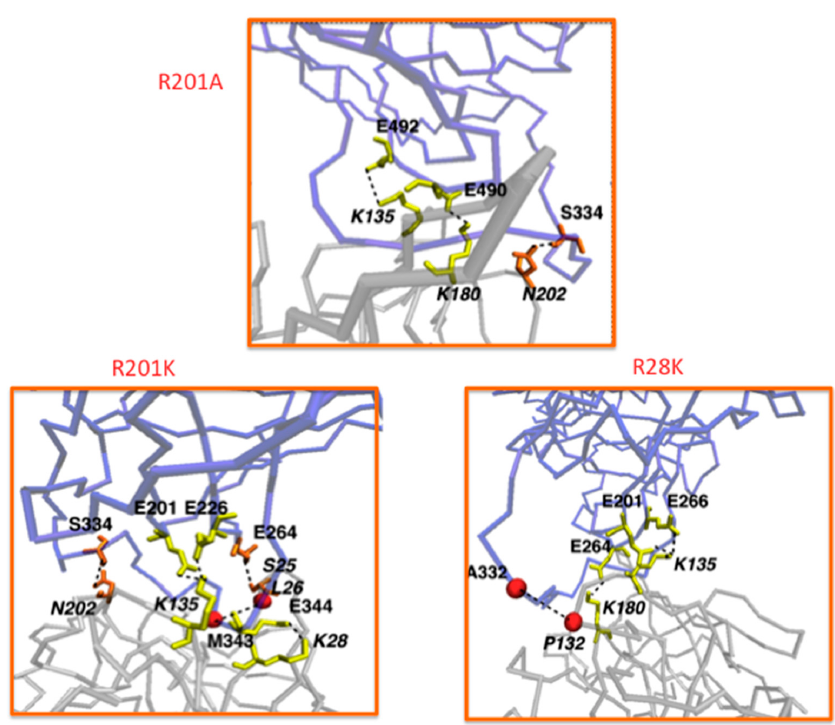
Figure 1. Contacts (yellow = salt bridges; orange = hydrogen bonds; red = hydrophobic interactions) left at the interface between PI9 (violet) and GrB (silver) after 50 ns MD simulation. Top = GrB mutant R201A; bottom left = R201K; bottom right = R201K.